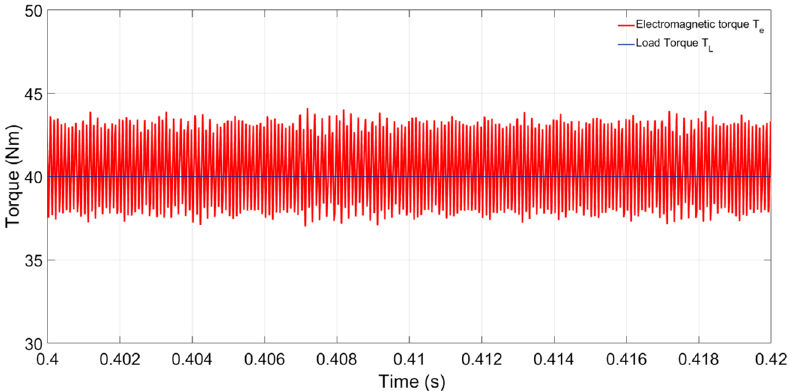
Figure 8. Torque waveform with 40 Nm for proposed rSVM-DTC (10 kHz).